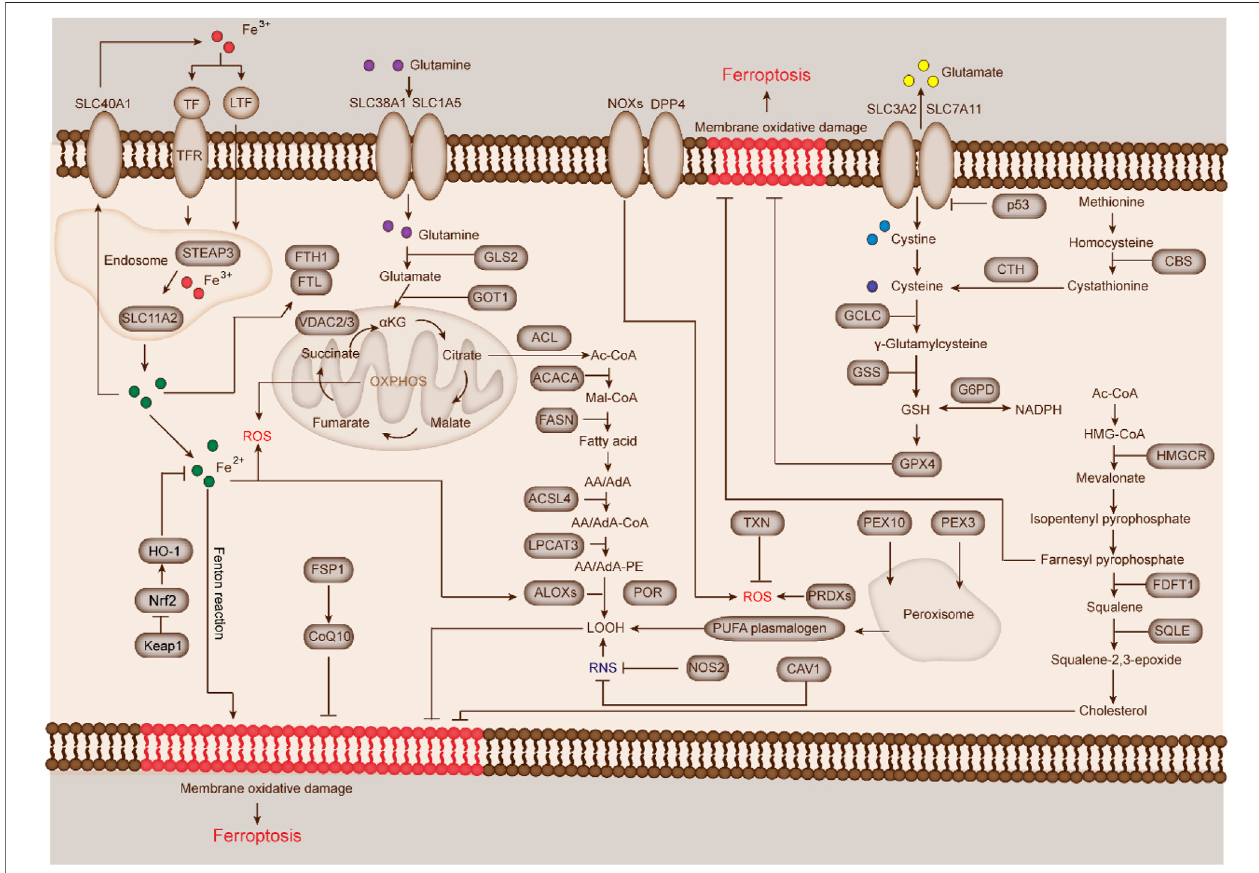
FIGURE 2 | Mechanisms and key regulators of ferroptosis. The major mechanisms and key regulators of ferroptosis can be roughly divided into two important mechanisms (iron metabolism and lipid peroxidation) and seven key regulators (system Xc − , GPX4, p53, acyl-CoA synthetase long-chain family member 4 [ACSL4], FSP1, and Nrf2). In addition, other mechanisms and regulators, such as p53/SLC7A11 and VDAC2/3 are also involved in lipid regulation and ferroptosis.